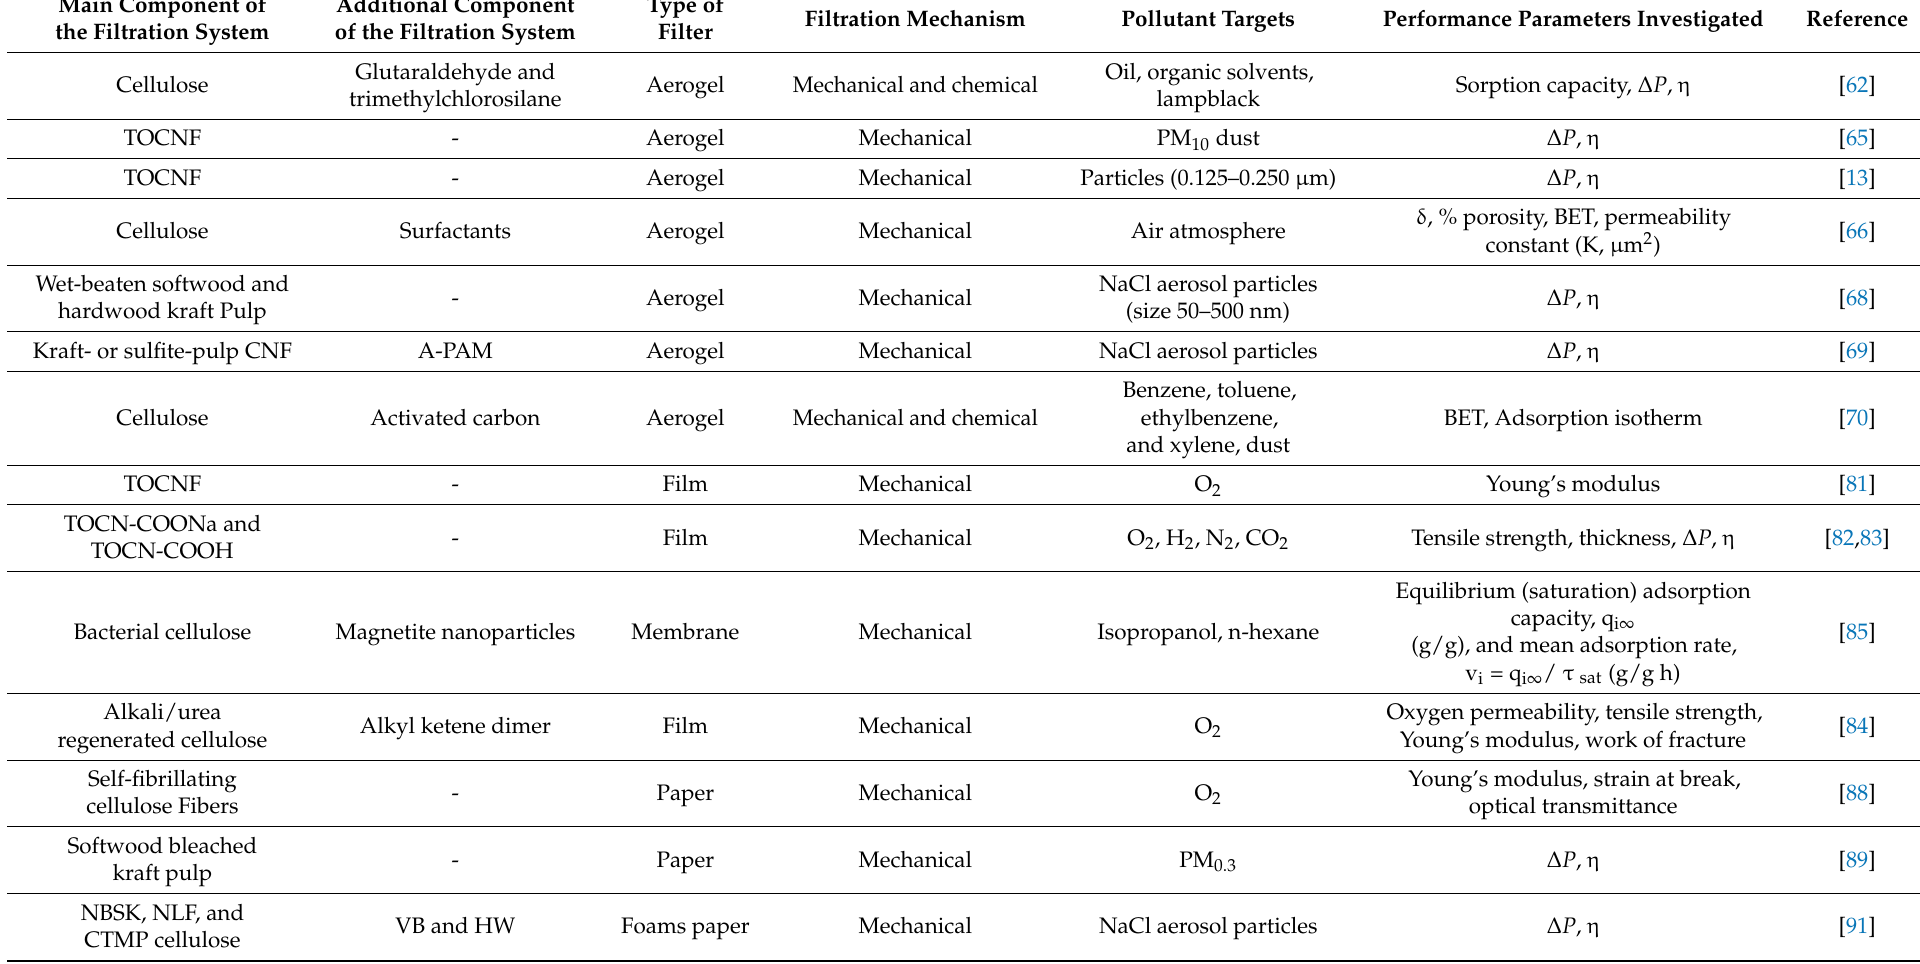
Table 1. Schematic summary of cellulose and nanocellulose-based materials and cellulose and nanocellulose-reinforced materials used as air filtering